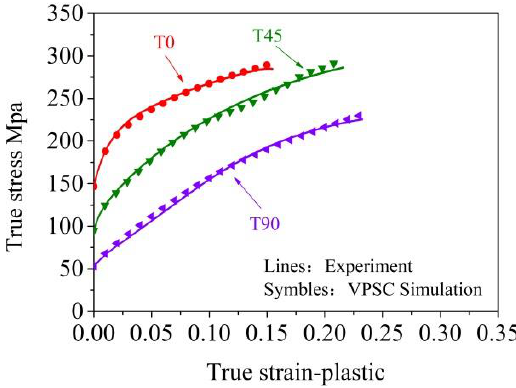
Figure 4. Fitting results of true stress–strain curves of different samples.